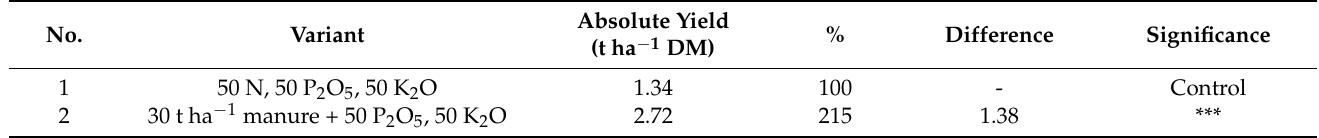
Table 2. The influence of the fertilization system on the production of temporary grassland (t ha − 1 DM, 2017).